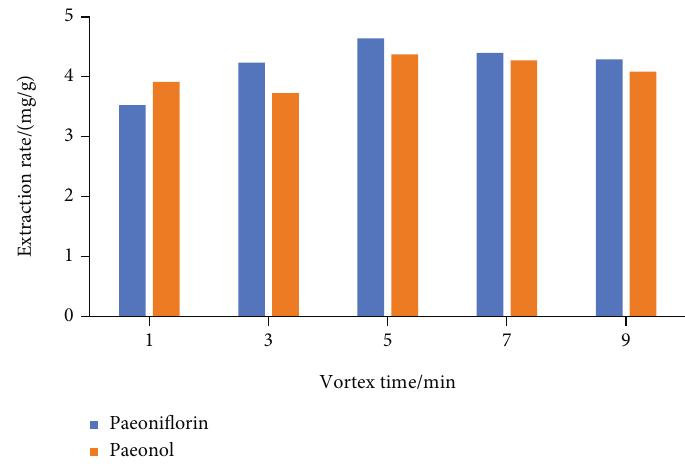
Figure 8: E ff ect of vortex time on Moutan Cortex extraction e ffi ciency. Table 4: Response surface test factors and horizontal design.